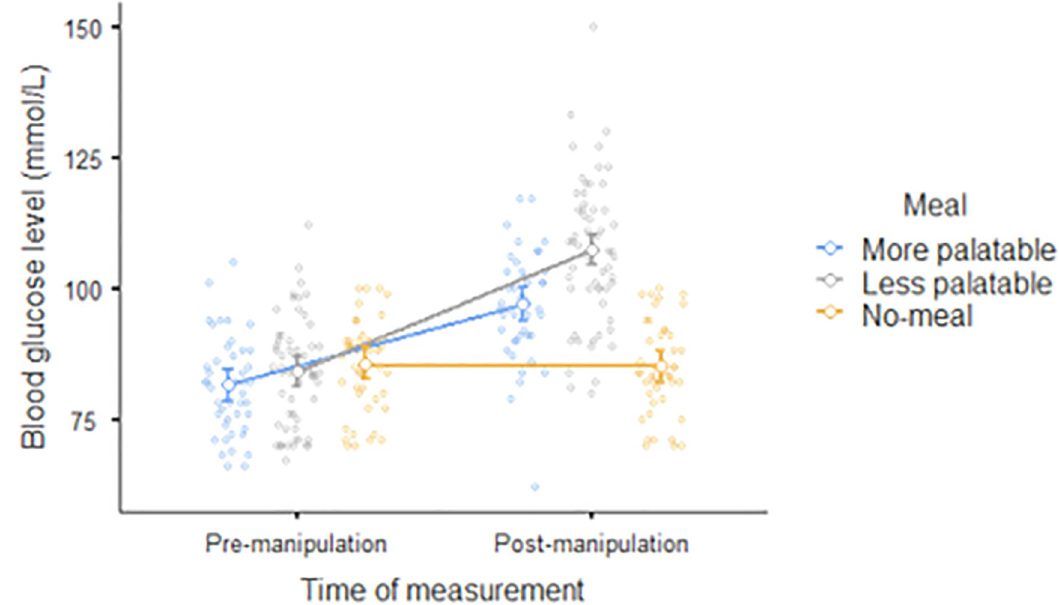
Fig 3. Mean pre-manipulation and post-manipulation levels of blood glucose for three groups varying in meal consumption. Dots indicate observed scores.